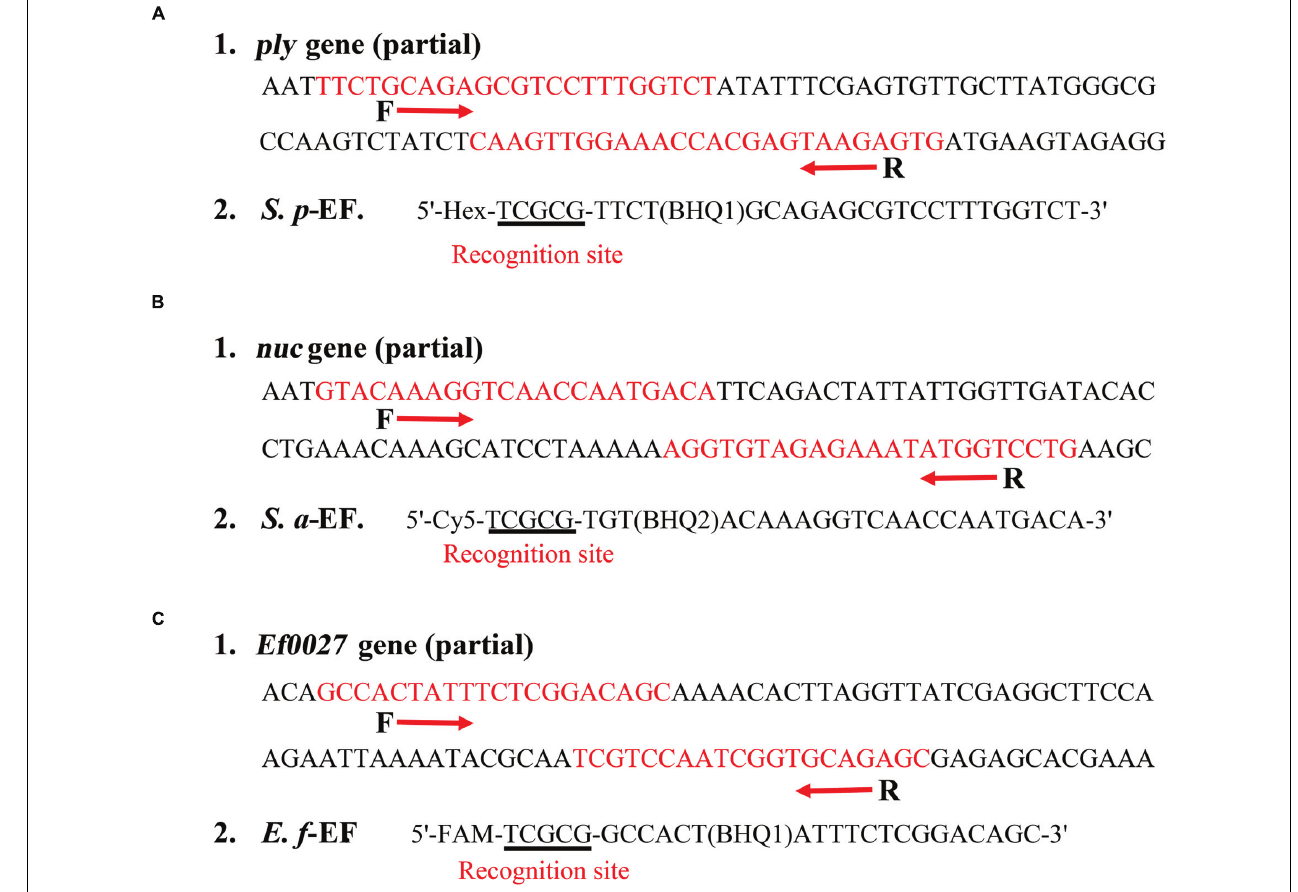
FIGURE 2 | The scheme lists the design and sequences of three sets of ET-PCR primers. (A1) , (B1) , and (C1) : The nucleotide sequences of the sense strand of ply gene (part), nuc gene (part) and Ef0027 gene (part) are shown. The locations of the primer sites are marked in red, right and left arrows indicate the sense and complementary sequences that are used. (A2) , (B2) , and (C2) : The modifications and sequences of three EF primers. The restriction enzyme recognizing sites are underlined.